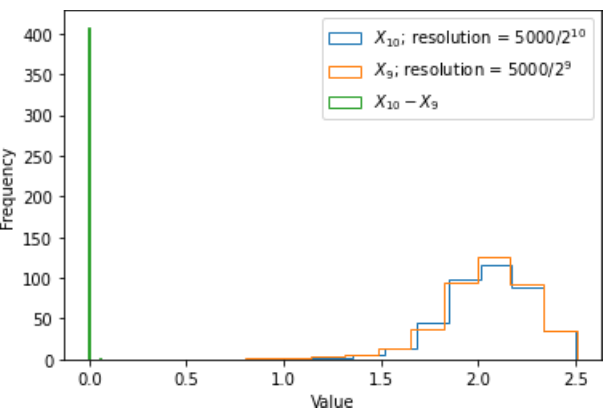
Figure 3. Distribution of outputs generated by XBeach for the hy- pothetical scenario at the finest resolution and at the second finest resolution considered, as well as the distribution of the difference between these output values. Note that the distribution for the dif- ference between the output values is much narrower, meaning fewer samples are required to get a good estimate of the mean. For refer- ence, in this hypothetical scenario the variance at resolution (cid:49)x = 5000 / 2 9 m is 0.0587; the variance at resolution (cid:49)x = 5000 / 2 10 m is 0.0580; and the variance of the difference between outputs at [5000 / 2 9 , 5000 / 2 10 ]m is 9 . 82 × 10 − 6